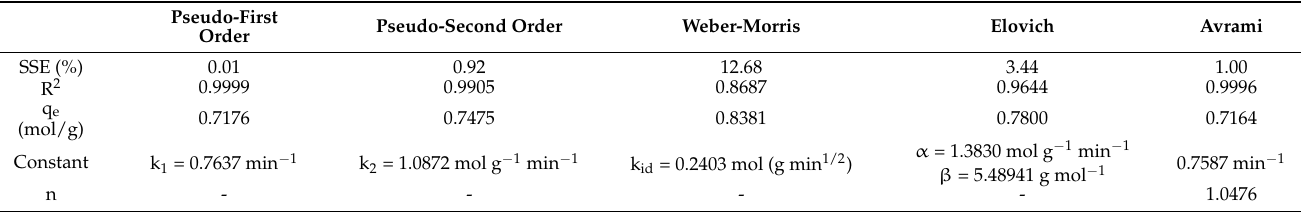
Figure 5. Fitting results of different adsorption kinetic model. Table 2. Fitting parameters of different adsorption kinetic model.